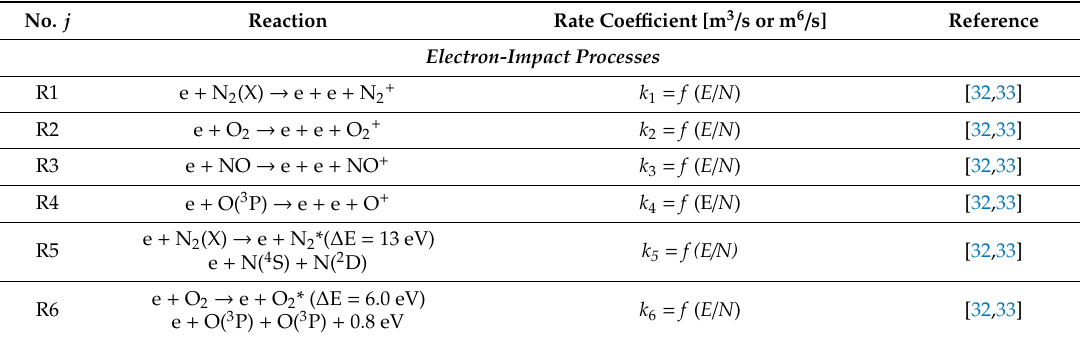
Table 1. List of reactions and rate coe ffi cients and applicable